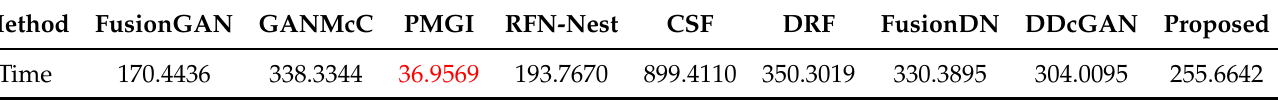
Table 6. The average running time of different methods for the TNO dataset (unit: